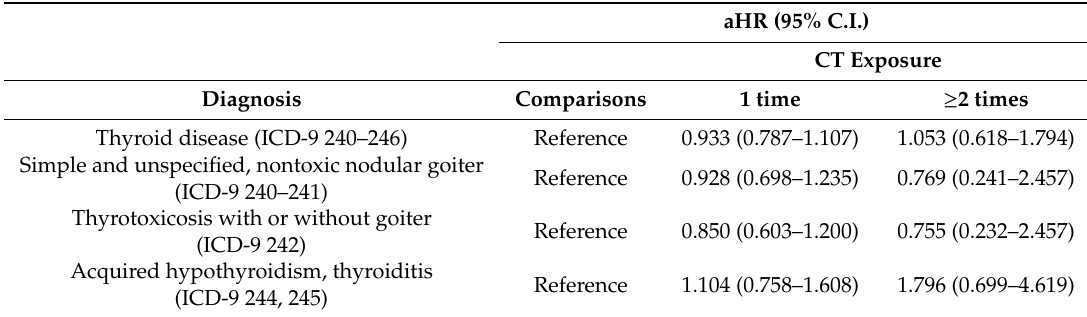
Table 4. Risk of subtypes of thyroid diseases in the CT scan